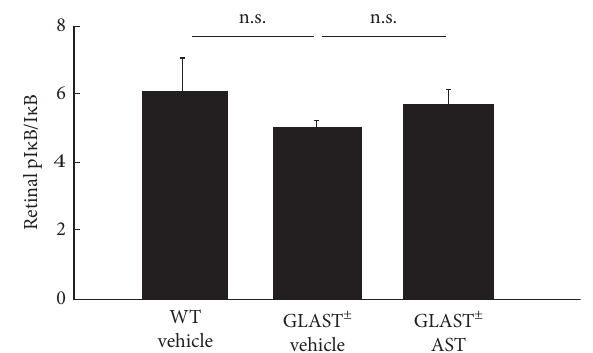
Figure 3: Raito of pI κ B/I κ B in the AST-administrated retina. Note that the pI κ B/I κ B ratio was not elevated in Glast ± mice compared with WTmice and did not change by ASTadministration. n.s.: not significant.